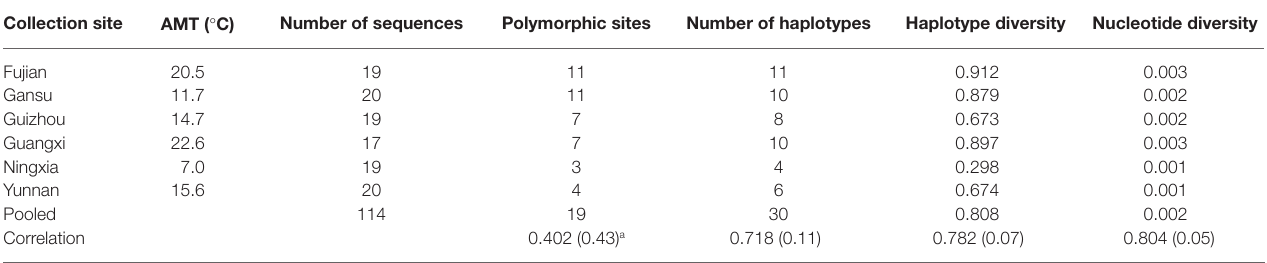
TABLE 1 | Sample size and sequence variation of Avr4 gene in the P. infestans populations collected from six locations in China and their correlation coefficients with annual mean temperature (AMT) at the collection sites. Collection